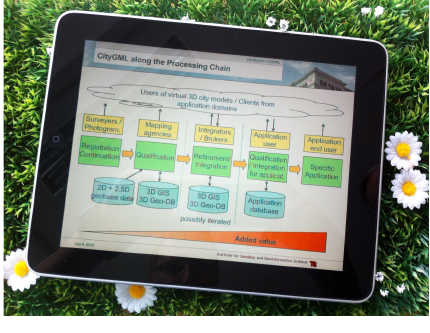
Figure 11: iPad with CityGML podcast http://www.igg.tu-berlin.de/podcasts/rss.xml